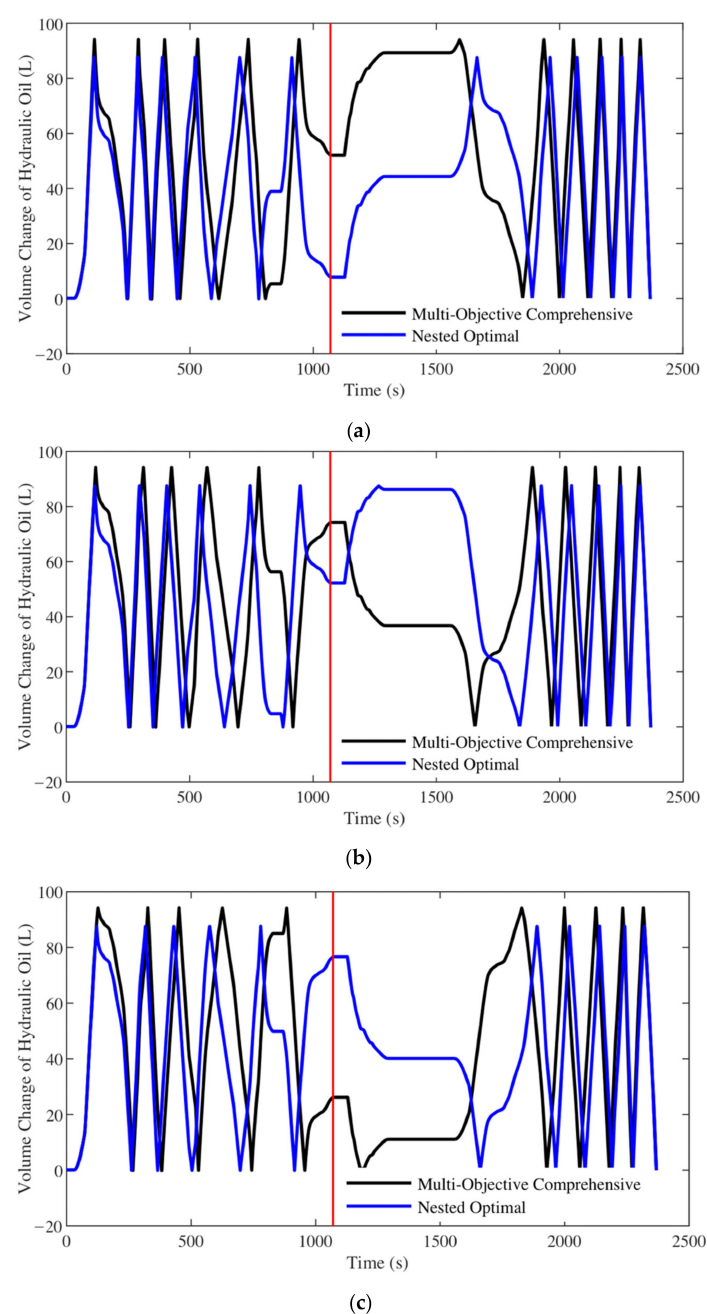
Figure 28. Volume change of hydraulic oil at different temperatures: ( a ) − 30 ◦ C; ( b ) 0 ◦ C; ( c ) 25 ◦